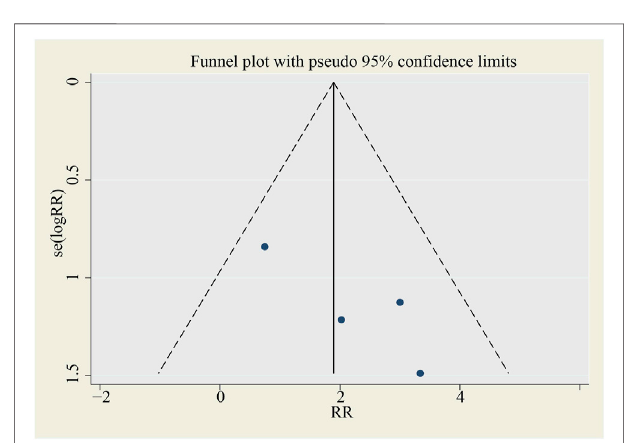
FIGURE 12 | Funnel plot for SAE (all-cause death). SMD, standardized mean difference, SE, standard error.